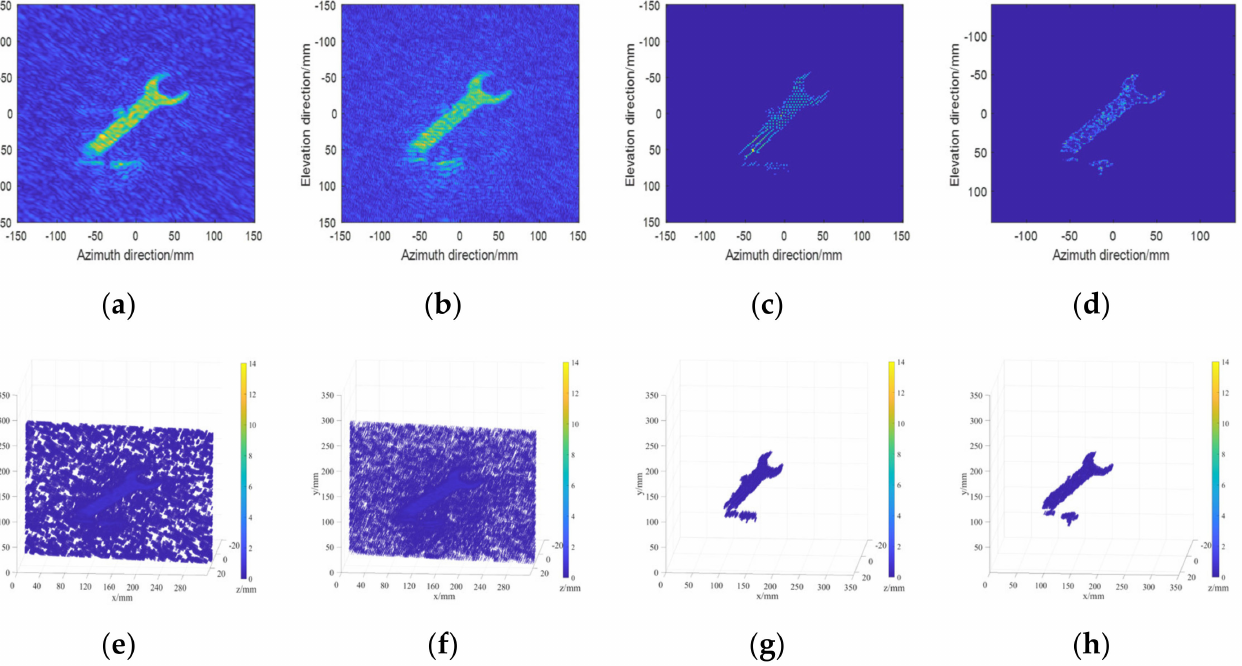
Figure 7. Imaging results. Row 1 ( a – d ) is the 2D wrench imaging results of the four imaging algorithms. Row 2 ( e – h ) is the 3D wrench imaging results of the four imaging algorithms. Column 1 is the BPA imaging results; Column 2 is the NUFFT-RMA imaging results; Column 3 is the OMP imaging results; Column 4 is the proposed method’s imaging